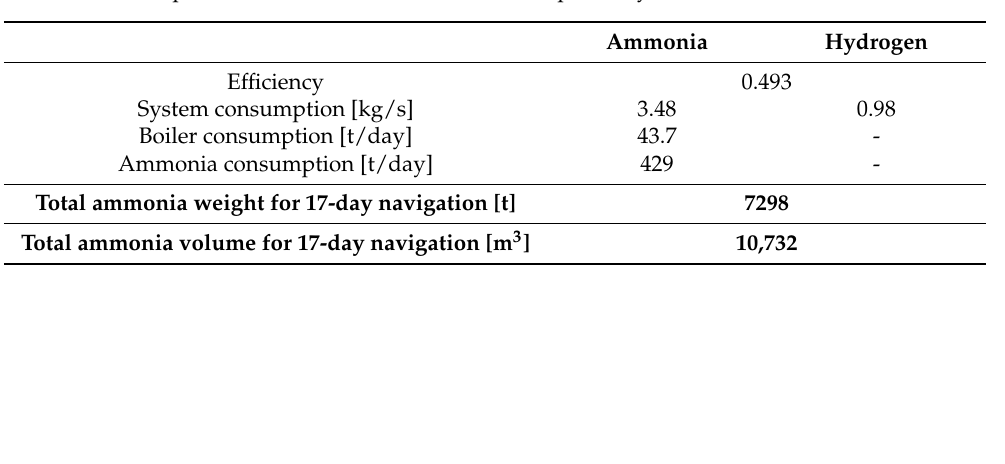
Table 8. Consumption calculations for ammonia-fueled power